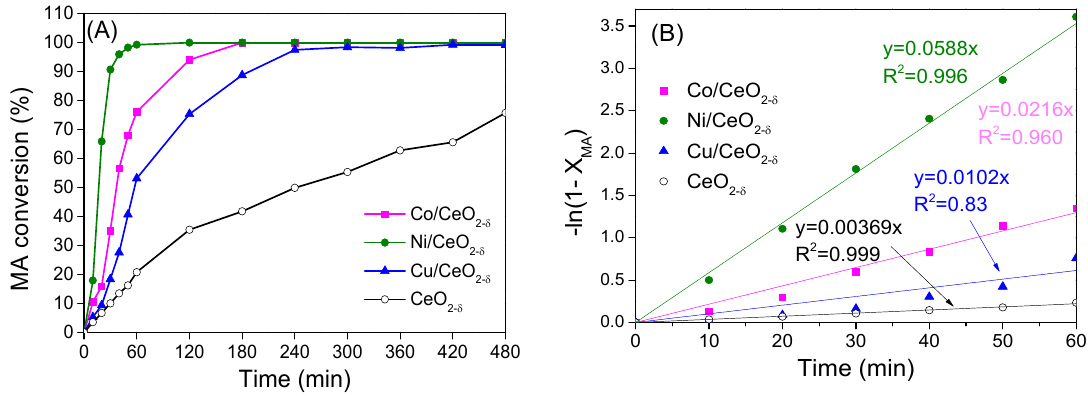
Figure 7. ( A ) The conversion of maleic anhydride (MA) and ( B ) the kinetic curves of the M/CeO 2 − δ catalysts.